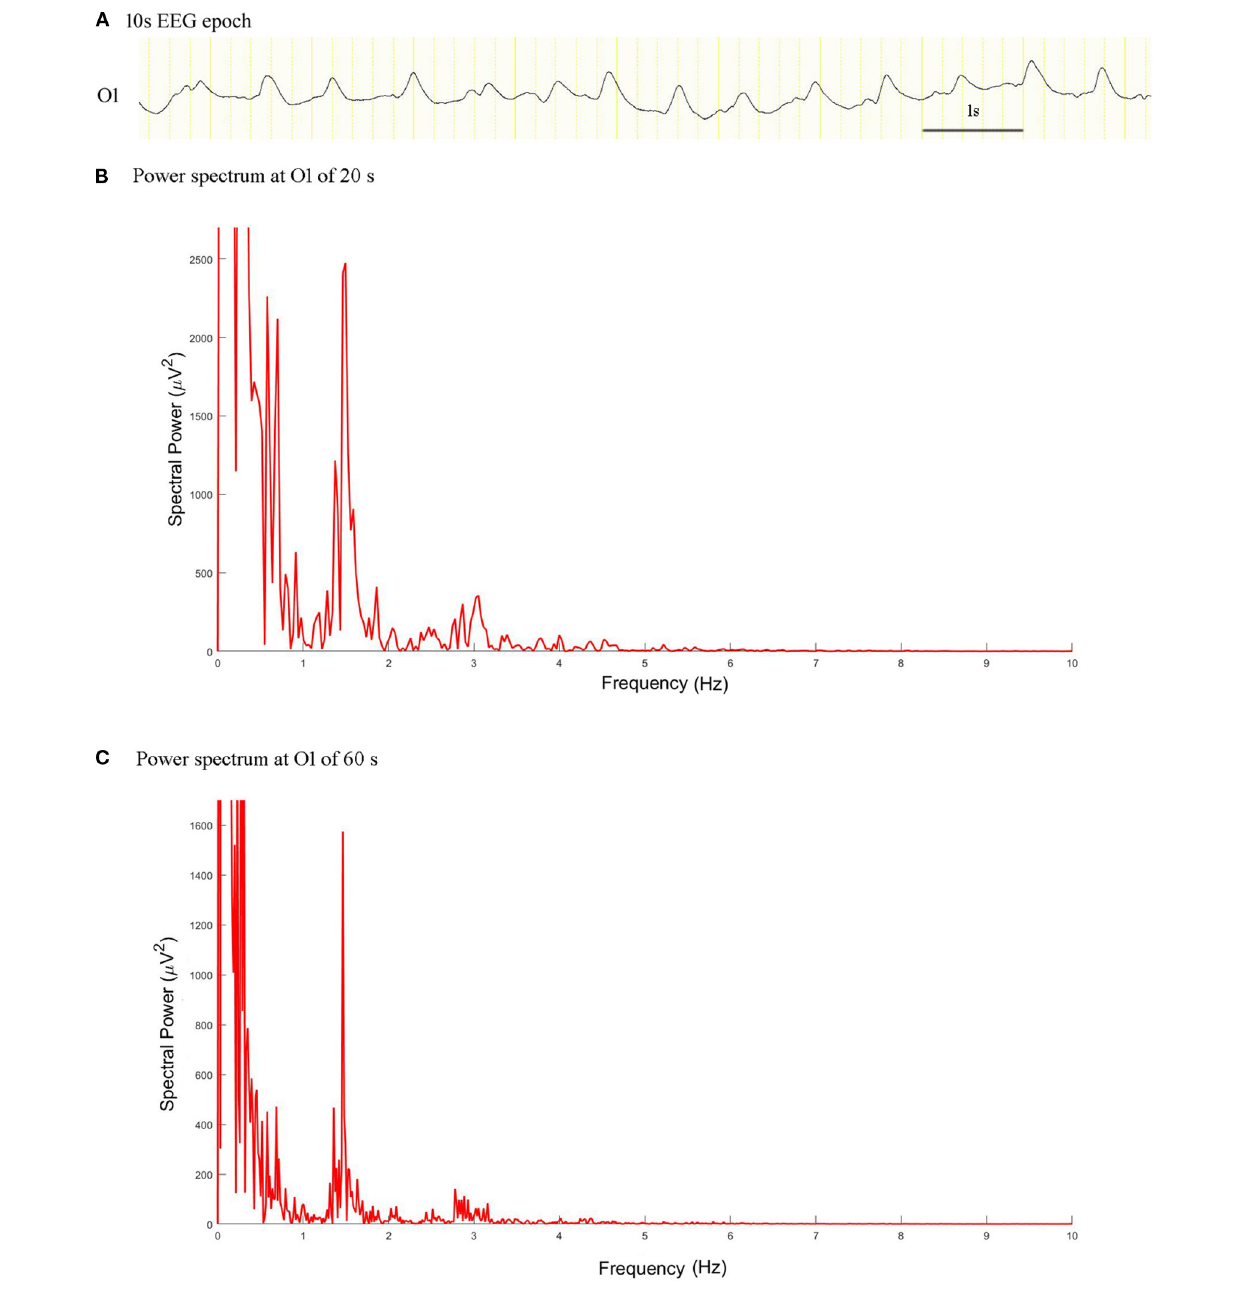
FIGURE 3 | EEG epoch and power spectrum with a window of 20 and 60s in a patient with intermediate duration PDs. (A) A 10s EEG epoch at O1 electrode. (B) The spectral peaks of PDs of 20s stood out of the background. (C) Power spectrum for PDs of 60s exhibited more prominent